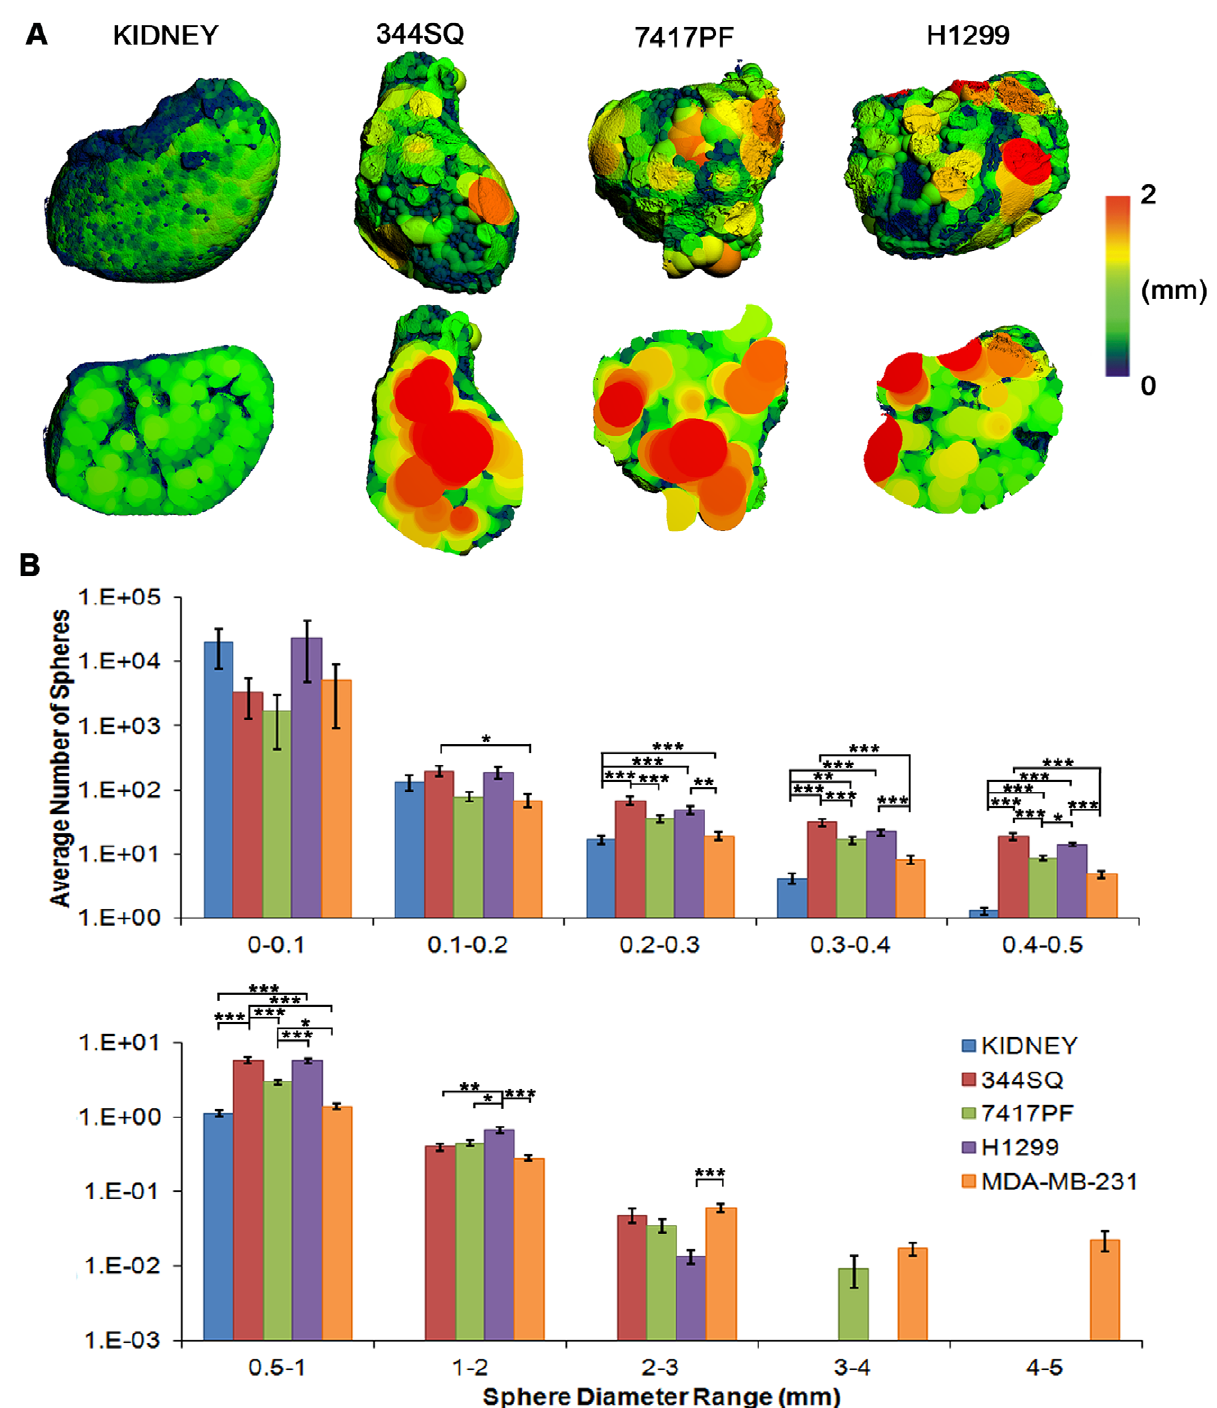
Figure 4. Imaging and quantification of avascular necrosis. ( A ) 3-D renderings from the kidney and NSCLC tumors following application of the maximal sphere-filling model; intact sample views above and cross-sectional images below (red indicating 2 mm or greater diameter of sphere). The presence of red (avascular) areas can be seen in all the tumor cell lines tested. ( B ) Histogram quantification of the maximal-spheres of two human and two murine cell lines by evaluating the total number of spheres present at increasing ranges of diameters (from 10 m m to 5 mm) (note the log scale on Y axis). Considerable variability is evident within both the vascularised and avascular areas within the tumors, with significantly more avascular areas being present in tumors, in contrast to the well-vascularized kidneys. Data indicate averages 6 s.e.m. (N=3–6 tumors per cell line). Asterisks indicate: * p , 0.05, ** p , 0.01, *** p , 0.001.